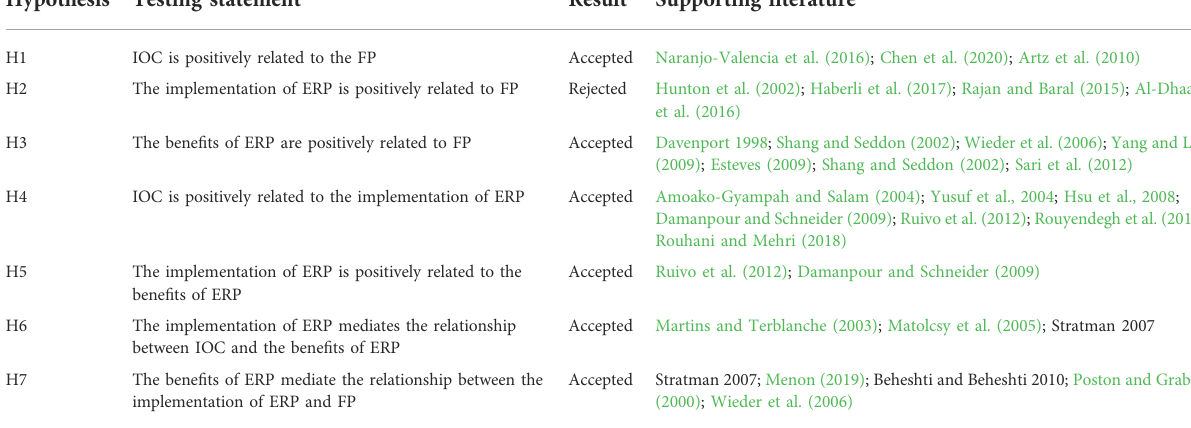
TABLE 6 Hypotheses testing and corresponding empirical